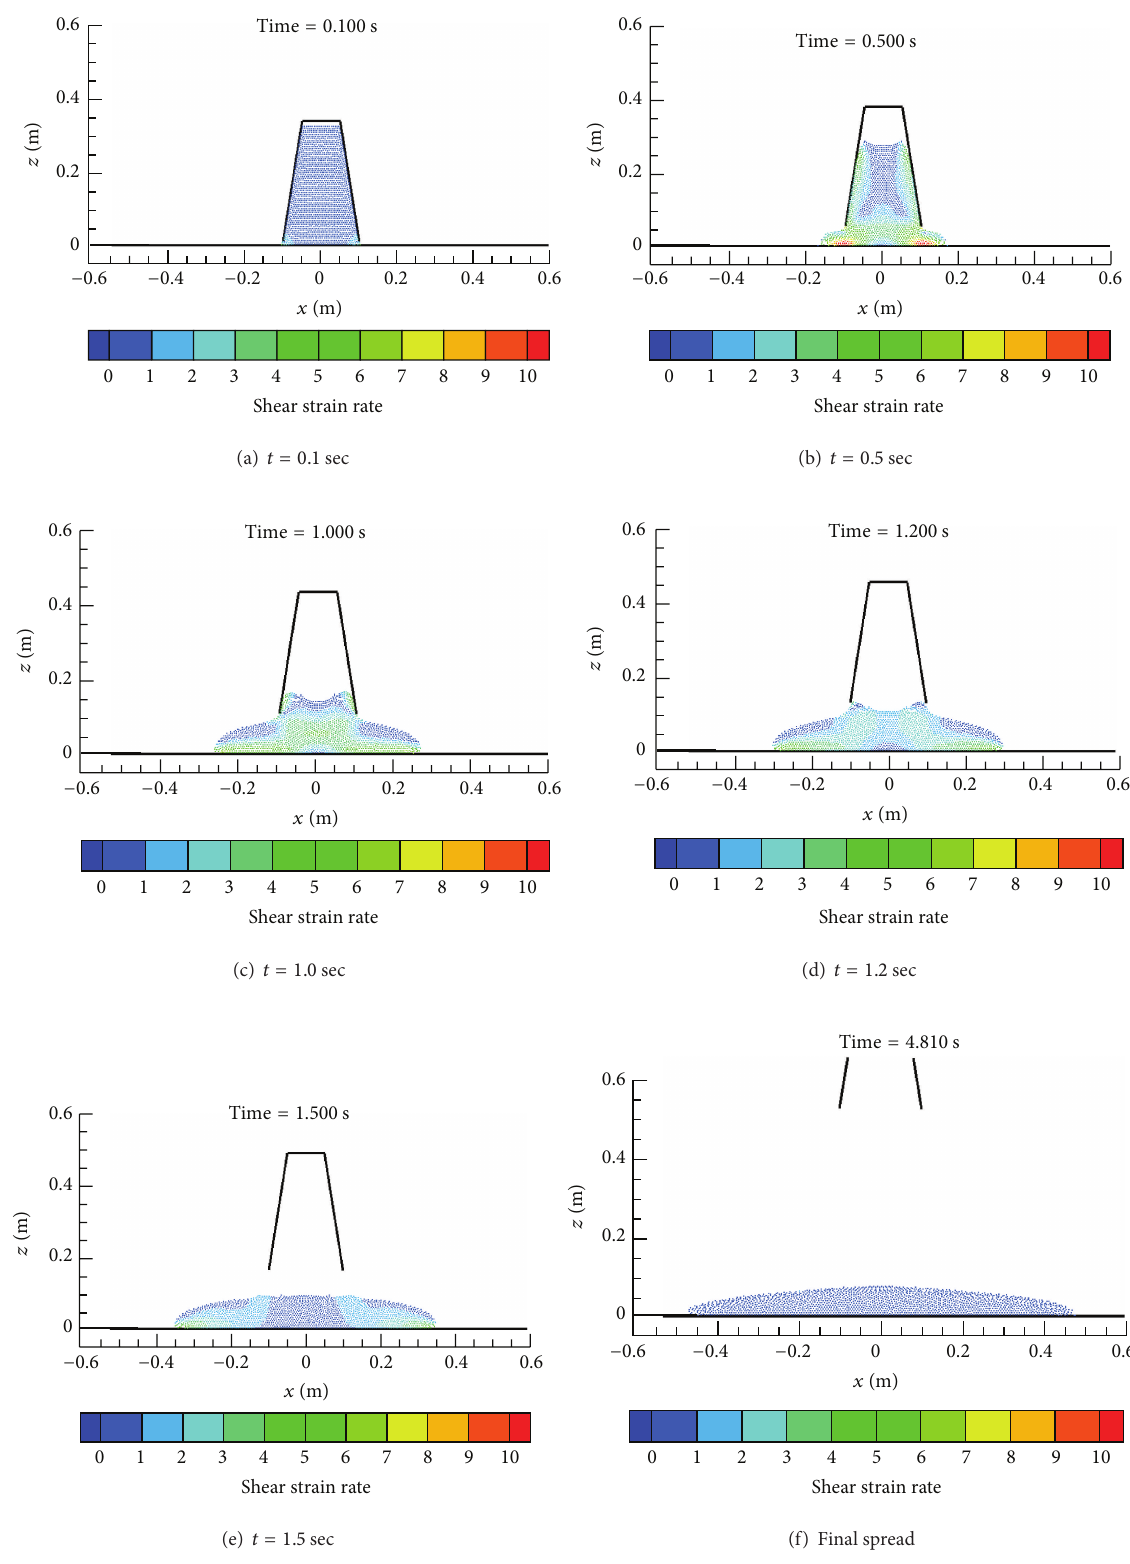
Figure 4: The shear strain rate distribution during slump